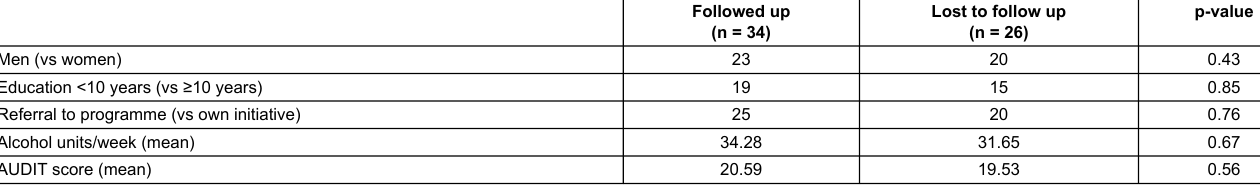
Table 4: Comparison of baseline characteristics between people continuing and lost to